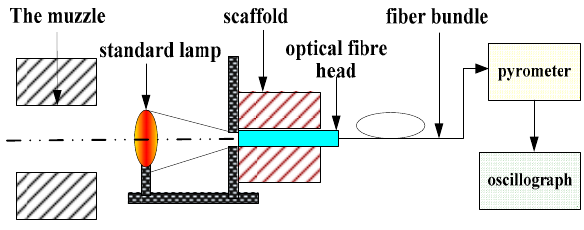
Figure 2. The calibration system of optical measurement.